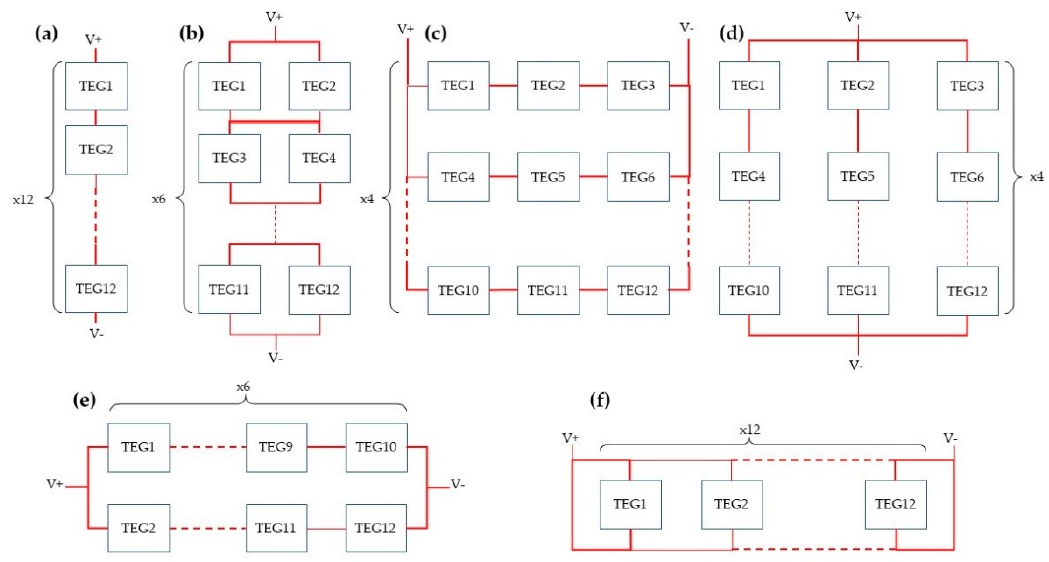
Figure 8. Configurations for multicell simulation analysis. ( a ) series of 12 cells, ( b ) 6 series of 2 parallel cells, ( c ) 4 parallels of 3 series cells, ( d ) 3 parallels of 4 series cells, ( e ) 2 parallels of 6 series cells and ( f ) 12 parallel cells.